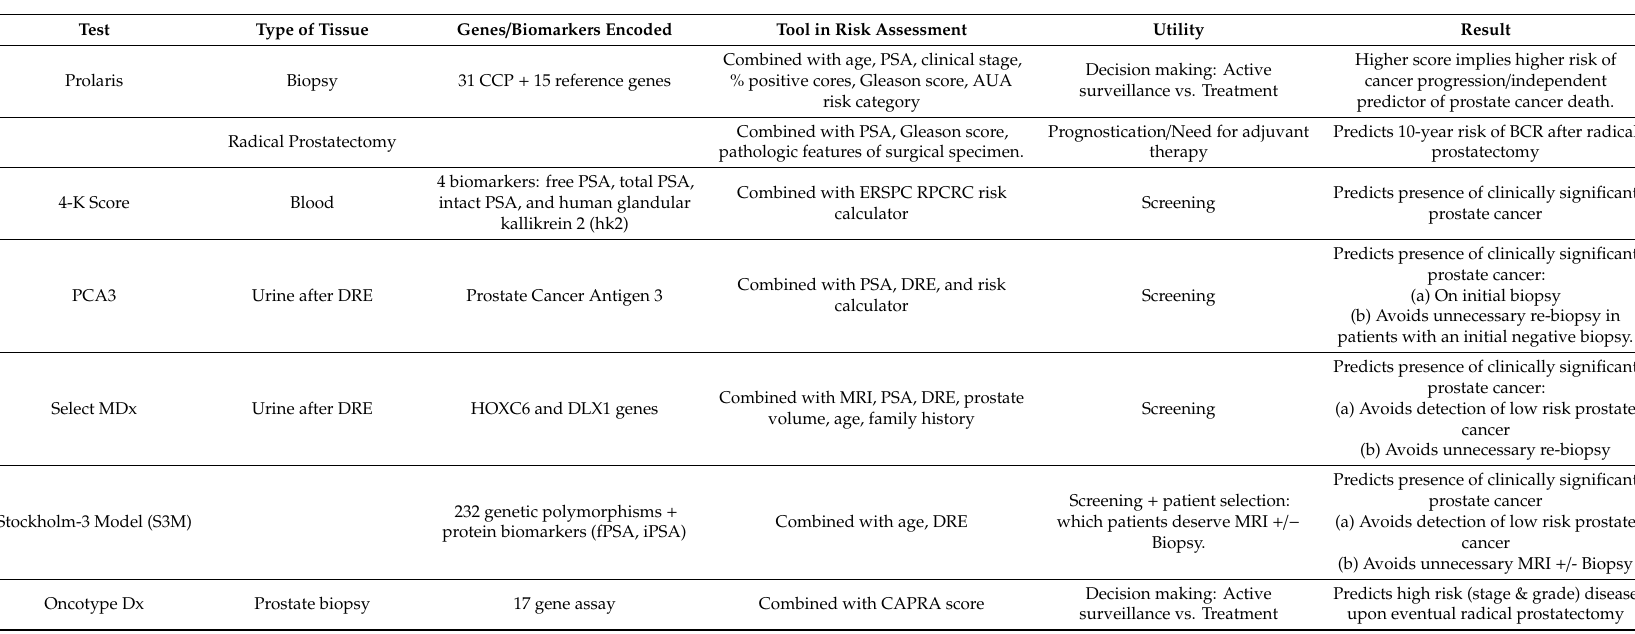
Table 1. Available biomarkers and risk assessment tools to guide prostate cancer treatment and decision